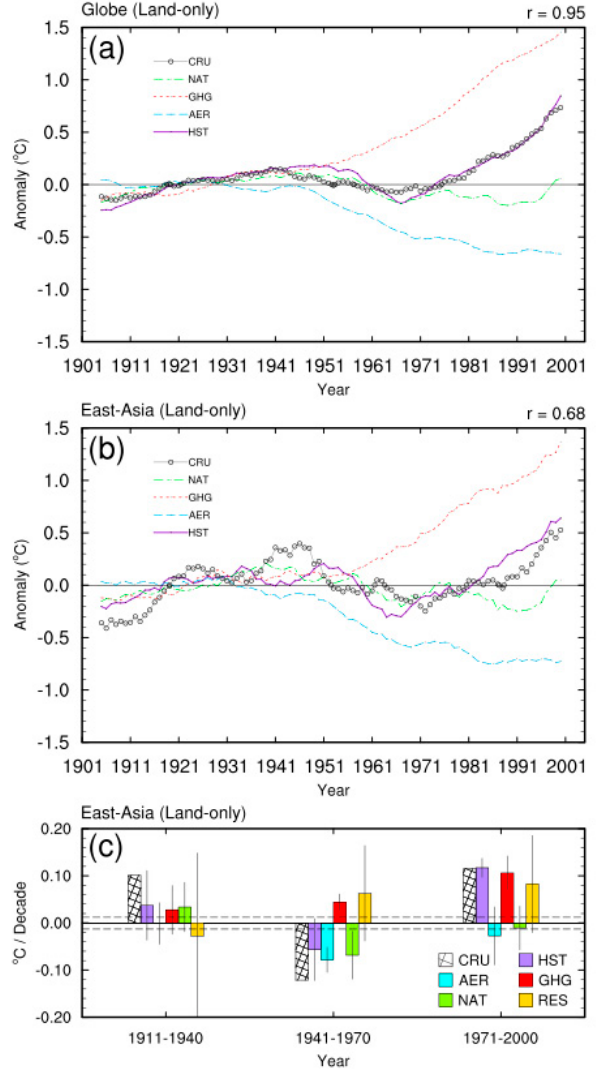
Figure 1. The June to August (JJA)-mean surface air temperature (TAS) time series in the 20th century from Climate Research Unit (CRU) and the GCM simulations over the land surface of ( a ) the entire globe and ( b ) EA, and ( c ) the linear trend of TAS obtained from the simulations in Table 2 and the corresponding residuals for the three periods. In ( a ) and ( b ), the 10 year running-mean TAS anomaly (1901–2005) over the entire globe and EA are shown. CRU indicates the CRU data and RES is the residual term calculated from the simulations as Equation (2); abbreviations for other runs are the same as in Table 2. Error bars indicate the standard deviation of CMIP5-model multi-model ensemble (MMEs) from each simulation. The black dashed horizontal lines indicate the range of the internal variability on the 30 year timescale estimated as one standard deviation of the 30-year trends of the 100 samples from the Pi-Control MME as described in Section 2.